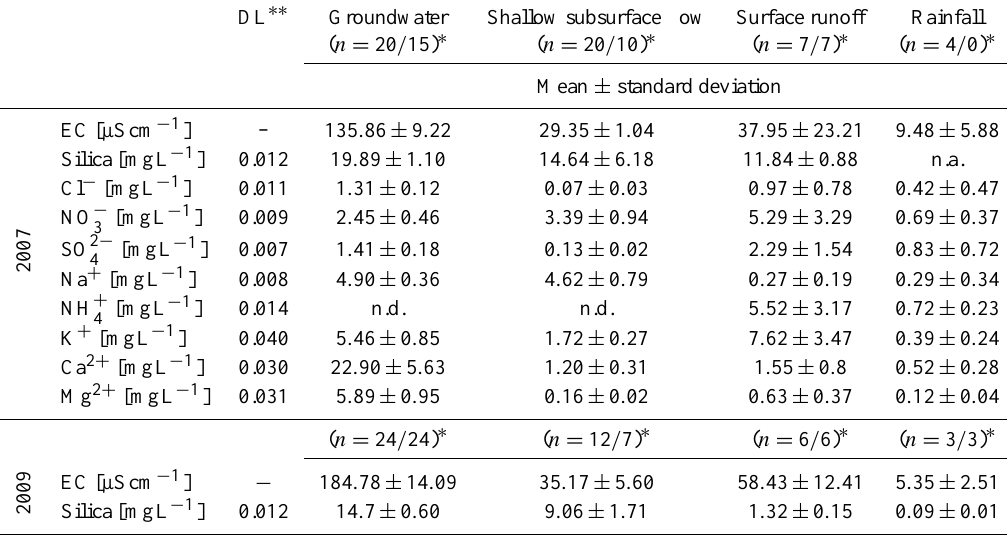
Table 3. Electrical conductivity and ion concentrations in water samples of groundwater, shallow subsurface flow, surface runoff and rainfall taken during September–October 2007 and August–September 2009. DL ∗∗ Groundwater Shallow subsurface flow Surface runoff Rainfall